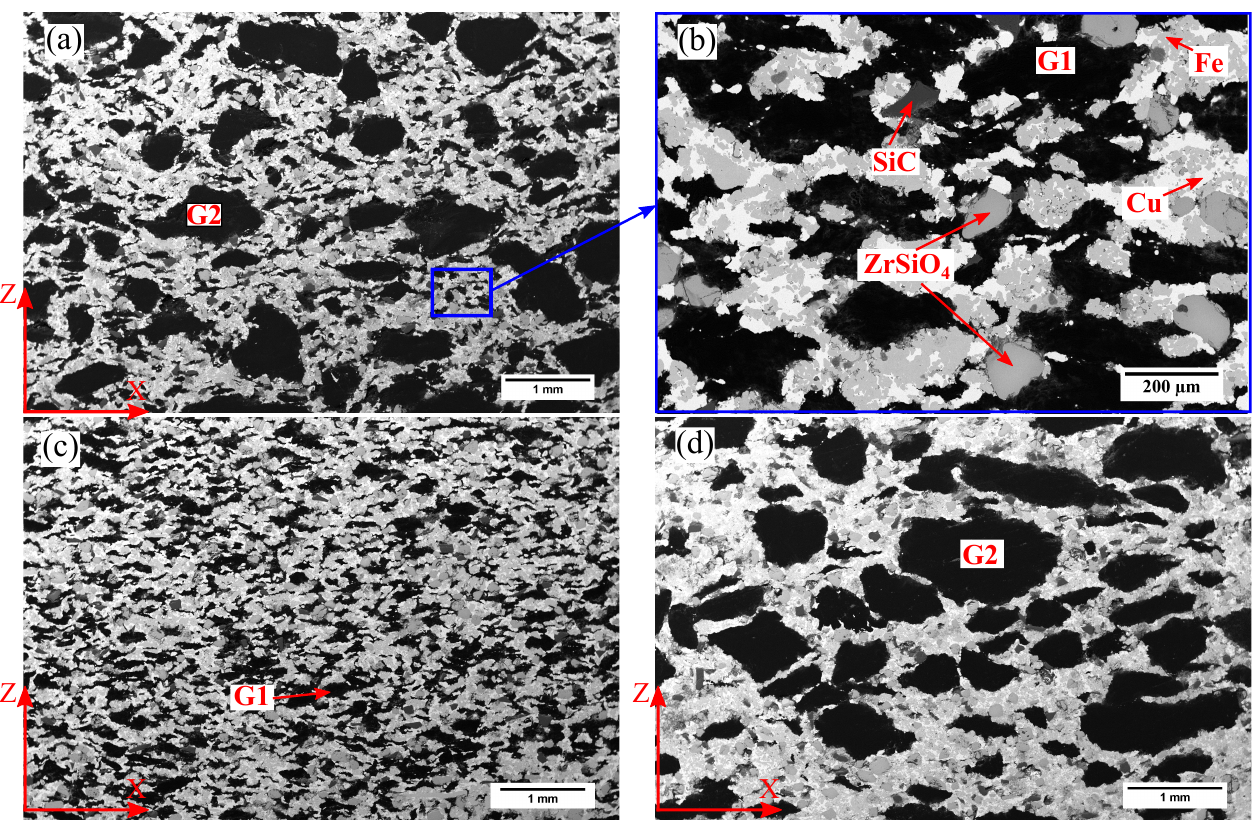
Figure 1. SEM Backscattered images of the ( a ) microstructure of the RM material at the macroscale. ( b ) microstructure of RM material at the mesoscale, ( c ) microstructure of MMCSG1 material at the macroscale, and ( d ) microstructure of MMCSG2 material at the